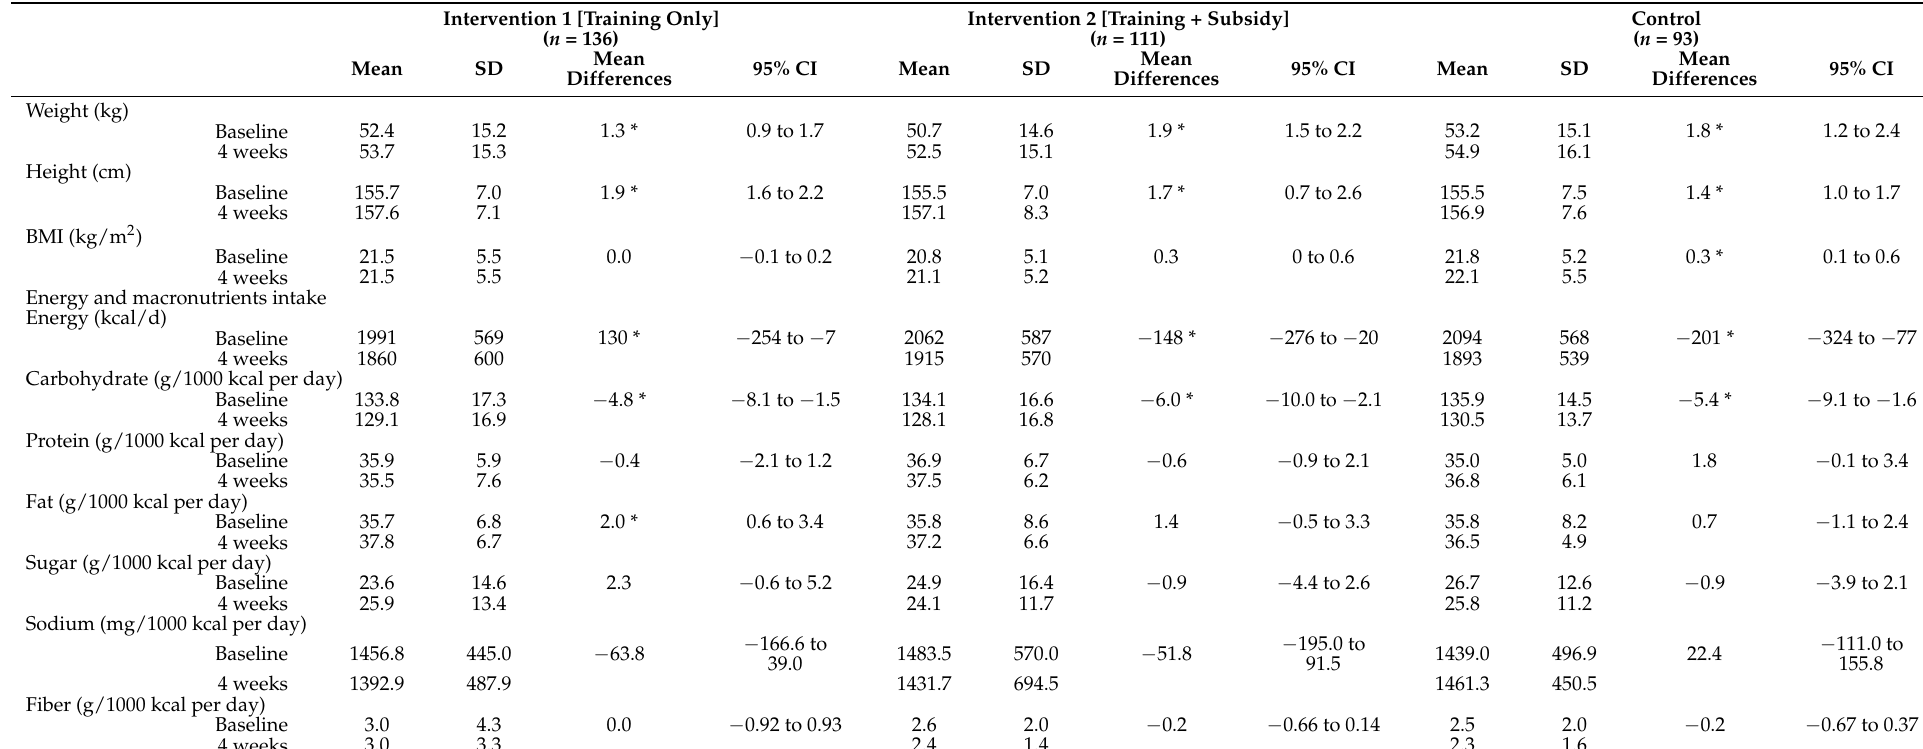
Table 2. Anthropometry and dietary intake measures at baseline and follow up of MyHeARTBeAT